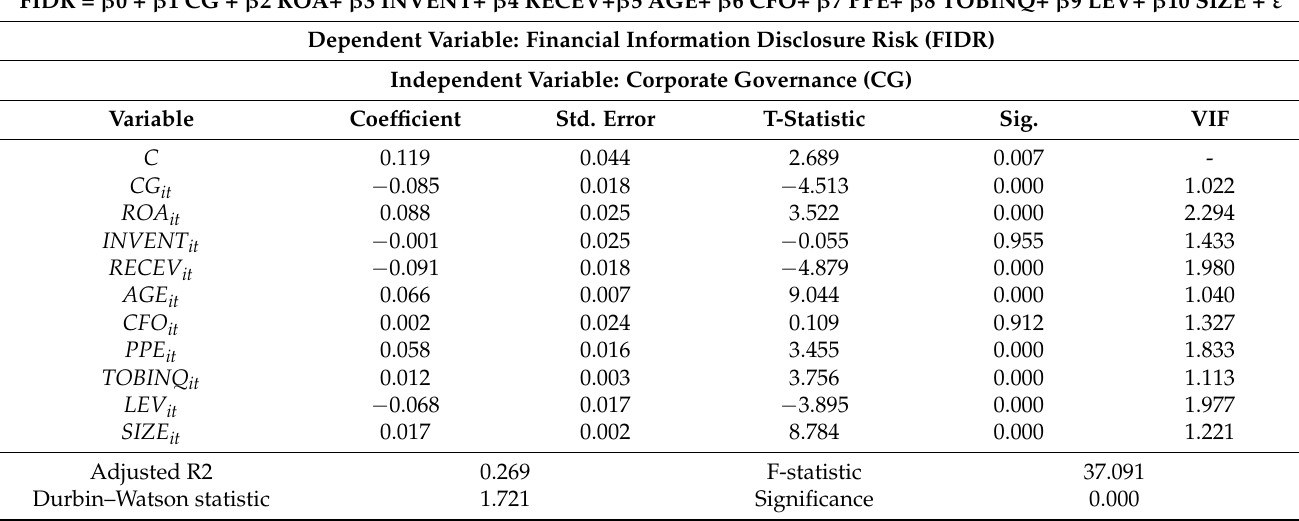
Table 9. Results of the statistical test of the second